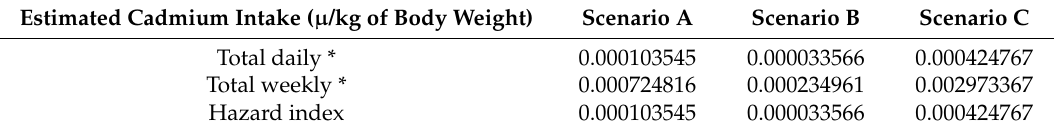
Table 8. Baroševac adult population’s weekly cadmium intake and hazard index (deterministic method). Estimated Cadmium Intake ( µ /kg of Body Weight)